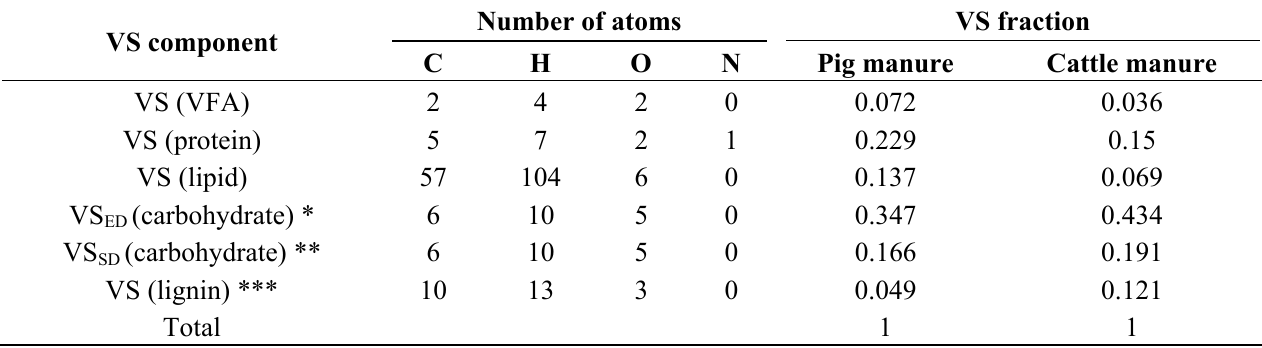
Table 3. Composition of the organic matter (VS) in pig and cattle manure [30].